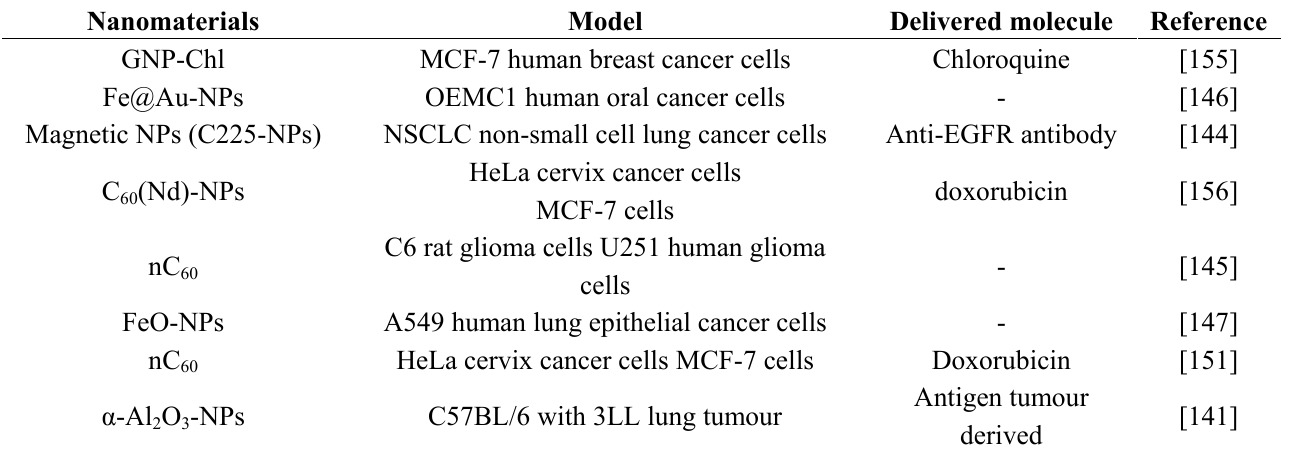
Table 2. A summary of NPs-mediated autophagy in cancer